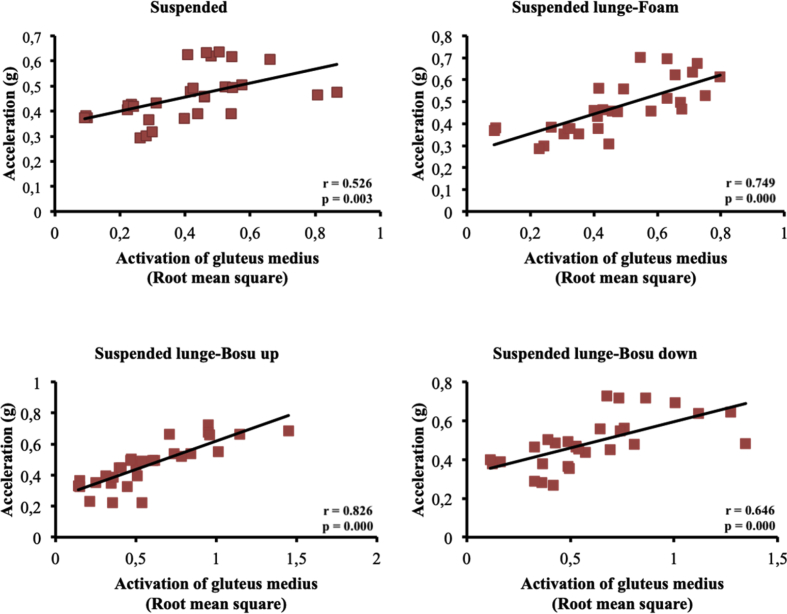
Correlation between gluteus medius activation and acceleration values under suspended lunge conditions.